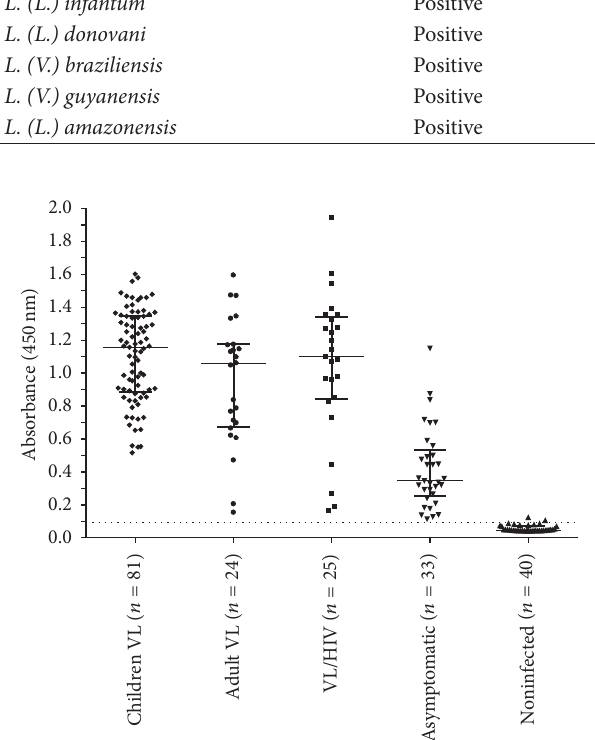
Figure 3: Circulating L. infantum DNA levels measured using the kDNA PCR-ELISA in different groups. kDNA PCR-ELISA absorbance results for the detection of PCR products from DNA extracted from peripheral blood samples in different groups of patients with VL, VL/HIV, asymptomatic, and noninfected endemic controls. There was no statistically difference between Adult VL and VL/HIV Groups ( 𝑝 = 0.38 ). In contrast, the median (0,347) in the Asymptomatic Group was lower than the Children VL Group ( 𝑝 < 0.0001 ). The dashed line represents the cut-off (0.096). Children VL Group: Median = 1.157, 25% Percentile = 0.886 and 75% Percentile = 1.345. Adult VL Group: Median = 1.057, 25% Percentile = 0.675 and 75% Percentile = 1.175. VL/HIV Group: Median = 1.099, 25% Percentile=0.842and75%Percentile=1.340.AsymptomaticGroup: Median = 0.347, 25% Percentile = 0.255 and 75% Percentile =